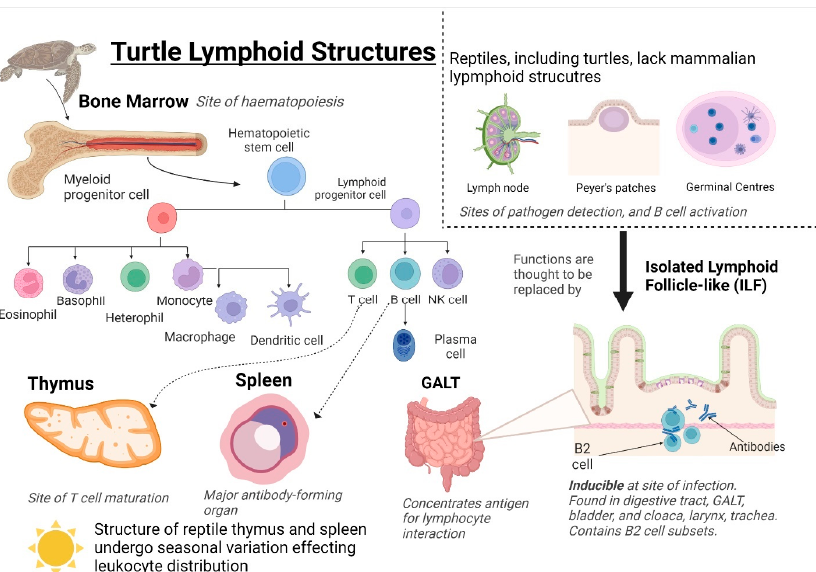
Figure 2. Turtle Lymphoid Structures. Primary structures include the bone marrow and thymus, and secondary structures include the spleen, Gut-associated lymphoid tissue (GALT), and isolated lymphoid follicle-like (ILFs). Hematopoietic stem cells are generated from the bone marrow and differentiate into myeloid progenitor cells or lymphoid progenitor cells. Myeloid progenitor cells differentiate into innate effector cells; granulocytes: basophils and eosinophils, and phagocytes: heterophils, monocytes, and macrophages. Lymphoid progenitor cells differentiate into adaptive immune effector cells: T and B cells. The distribution and differentiation of leukocytes are affected by seasonal variations in the structure of the spleen and thymus. Created using BioRender.